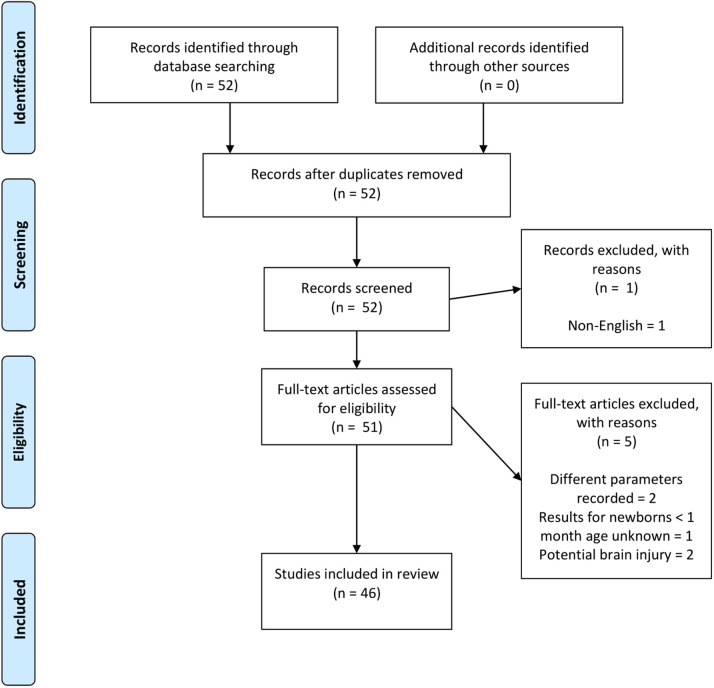
PRISMA chart showing papers identified, eligibility, and inclusion in this review paper. Note, two papers (Abboub et al., 2016; Ferry et al., 2016) were later identified that were not flagged using the defined search criteria. These are cited here but not included in the final analysis.